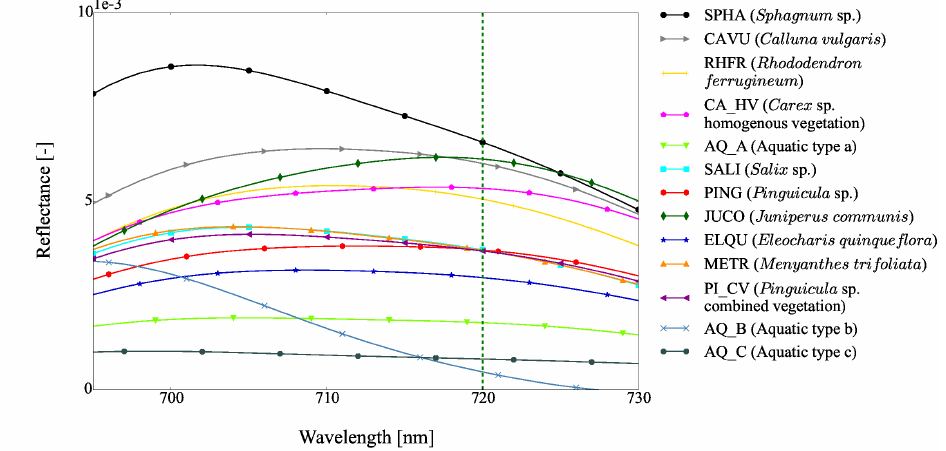
Figure 7. Mean first derivative spectral signatures of the 13 vegetation types on [695–730 nm]. The green dashed line represents the wavelength used by the Boochs2